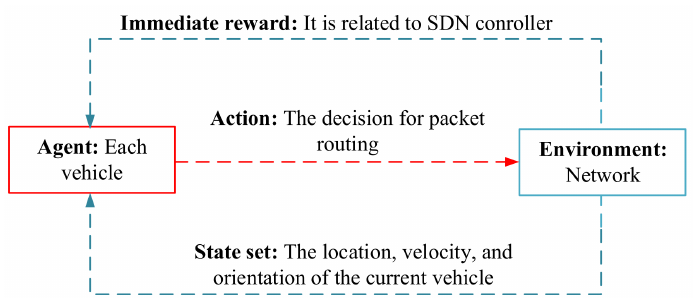
Figure 23. Learning structure in